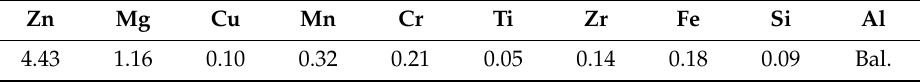
Table 1. Chemical composition of the 7020-aluminum alloy (wt.%).